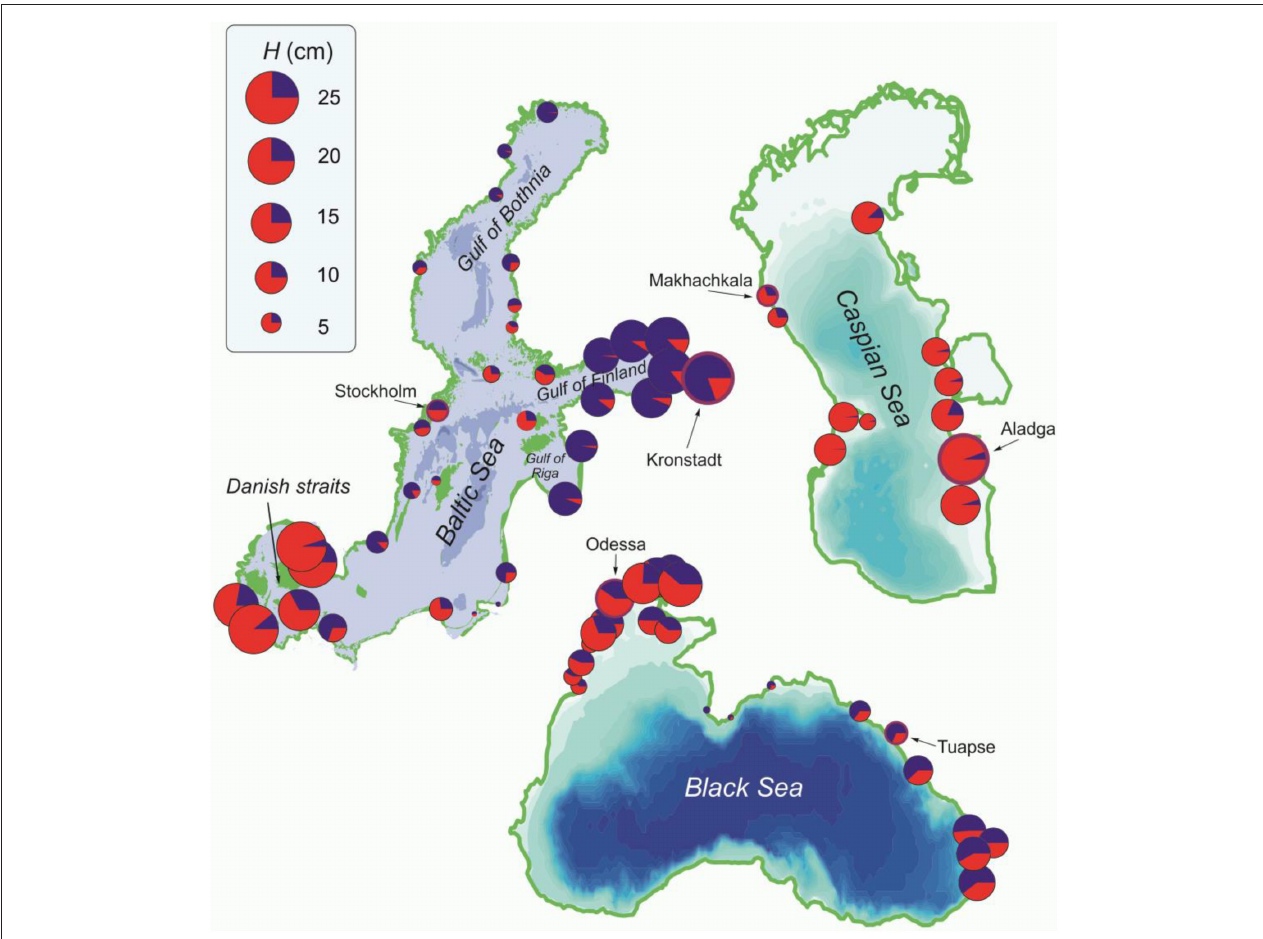
FIGURE 2 | Distribution of maximum tidal heights in the Baltic, Caspian, and Black seas evaluated for a 100-year period. The segment colors indicate relative contribution of diurnal (blue) and semidiurnal (red) energy into the total energy of the tidal oscillations.